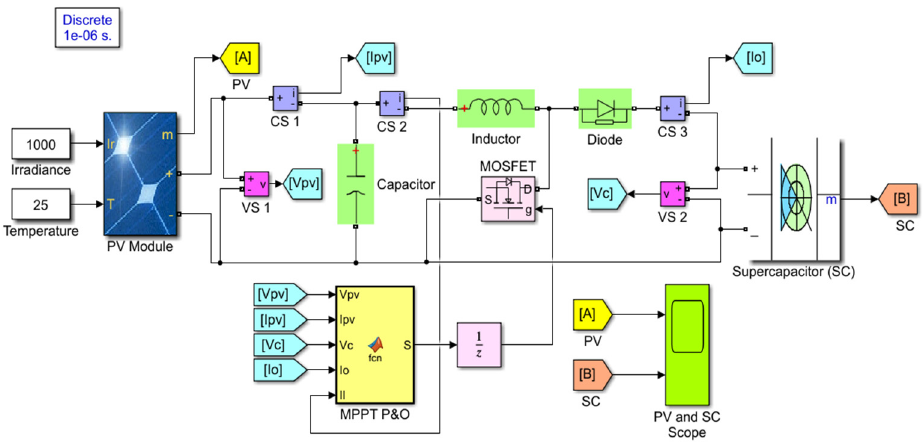
Figure 3. Proposed simulation model of the solar PV energy harvesting model.